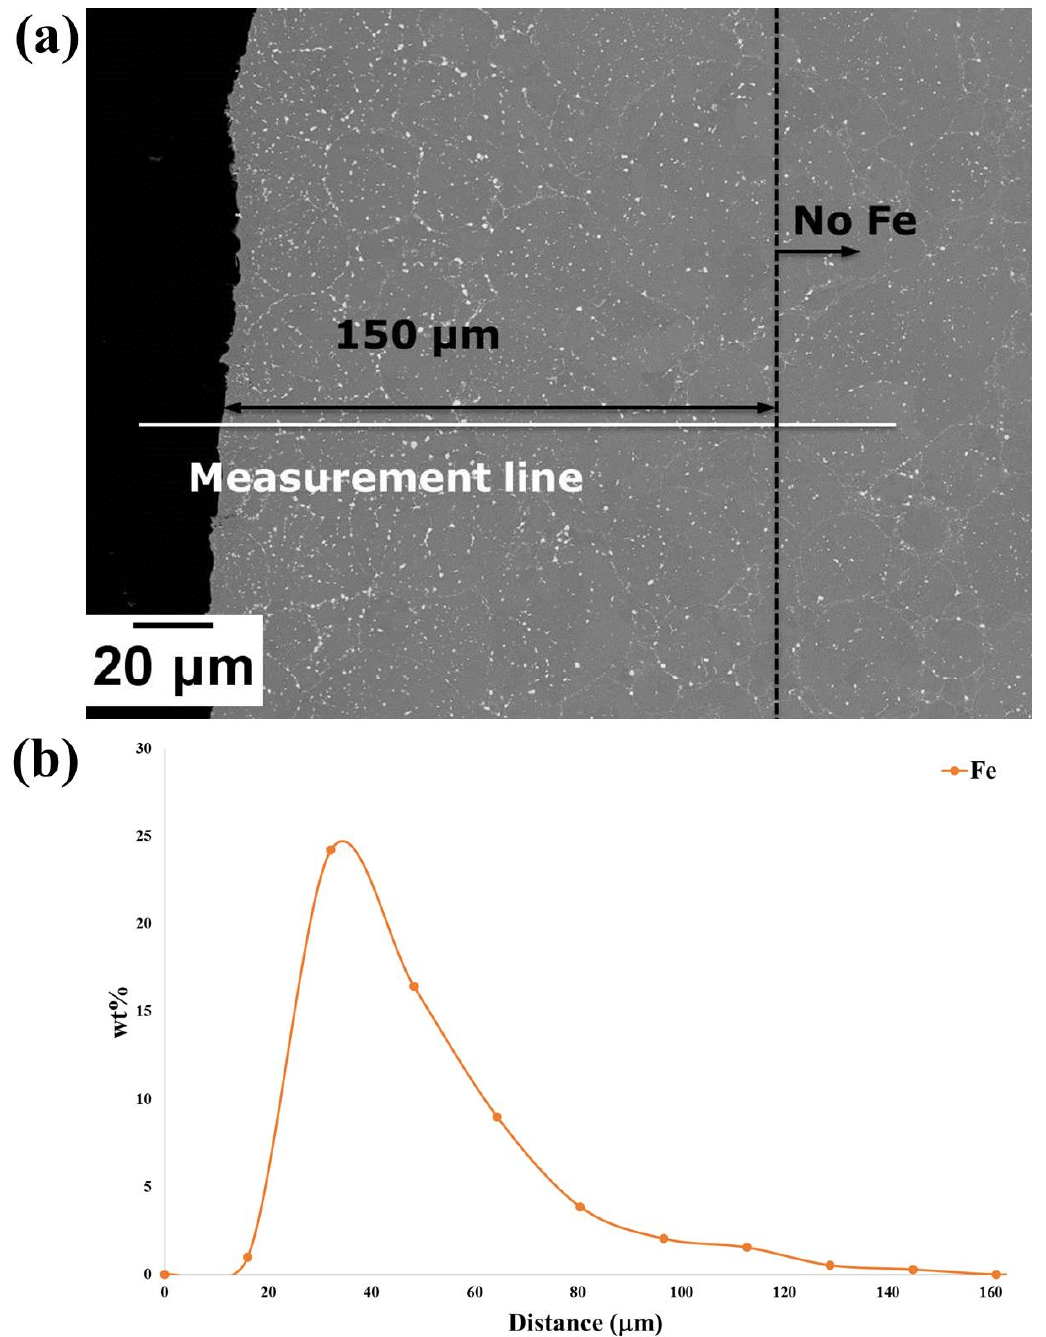
Figure 16. ( a ) BSE micrograph of the sample cut from the Fe-tooling SLM/HIPped blisk after pickling; ( b ) EDX line result along the measurement line indicated in (a); it is shown that Fe decreases to ~0 wt.% at around 150 µm.